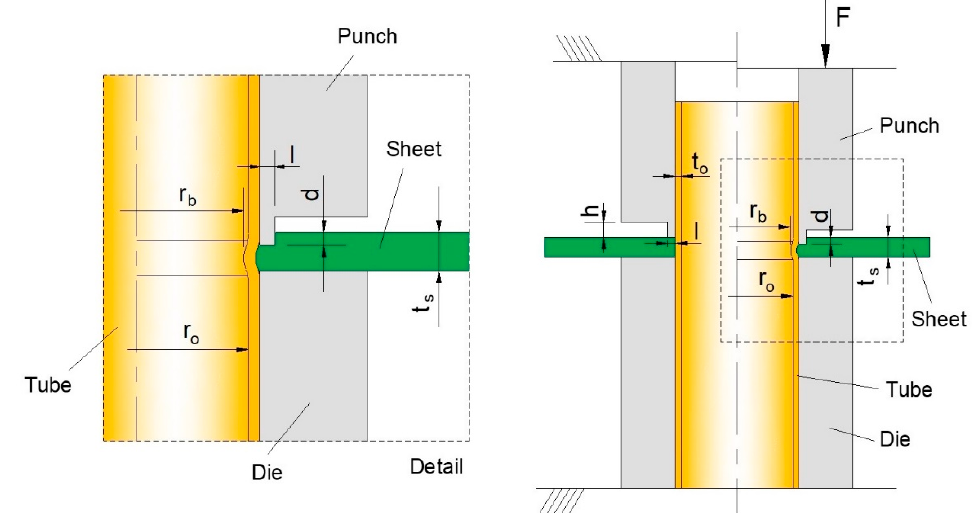
Figure 2. Schematic representation of the process and main variables for joining a sheet to a tube away from its end by annular sheet squeezing at the open and closed tool positions [12,14].